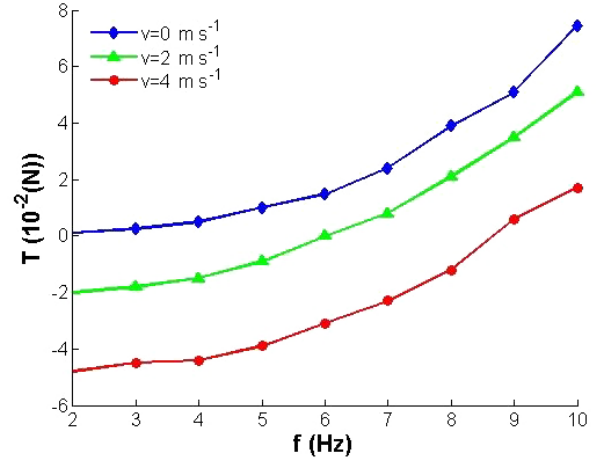
Figure 11. The average thrust force versus flapping frequency for different wind